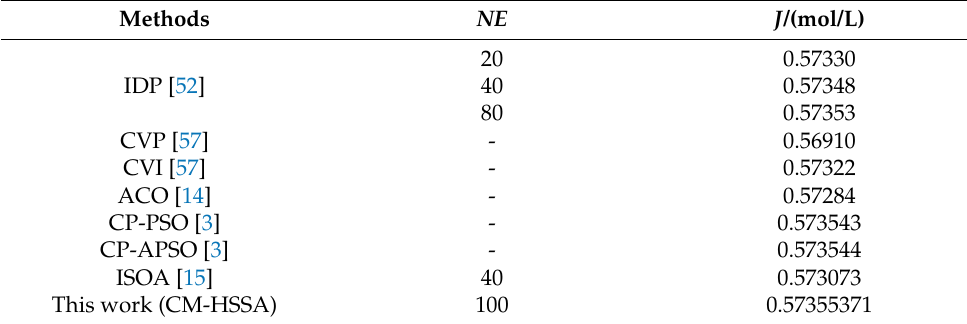
Table 9. Comparison of optimization results for Problem